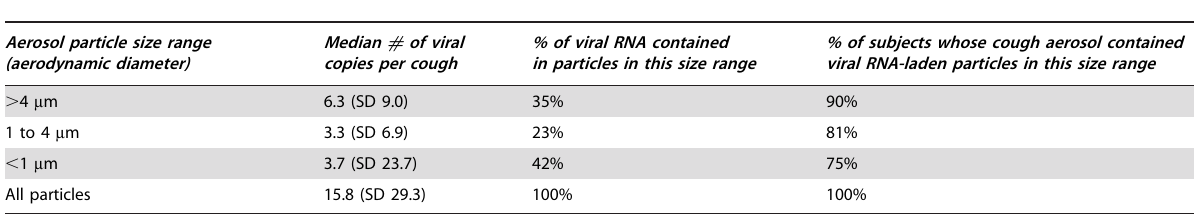
Table 1. Influenza viral RNA detected in the NIOSH two-stage aerosol sampler.